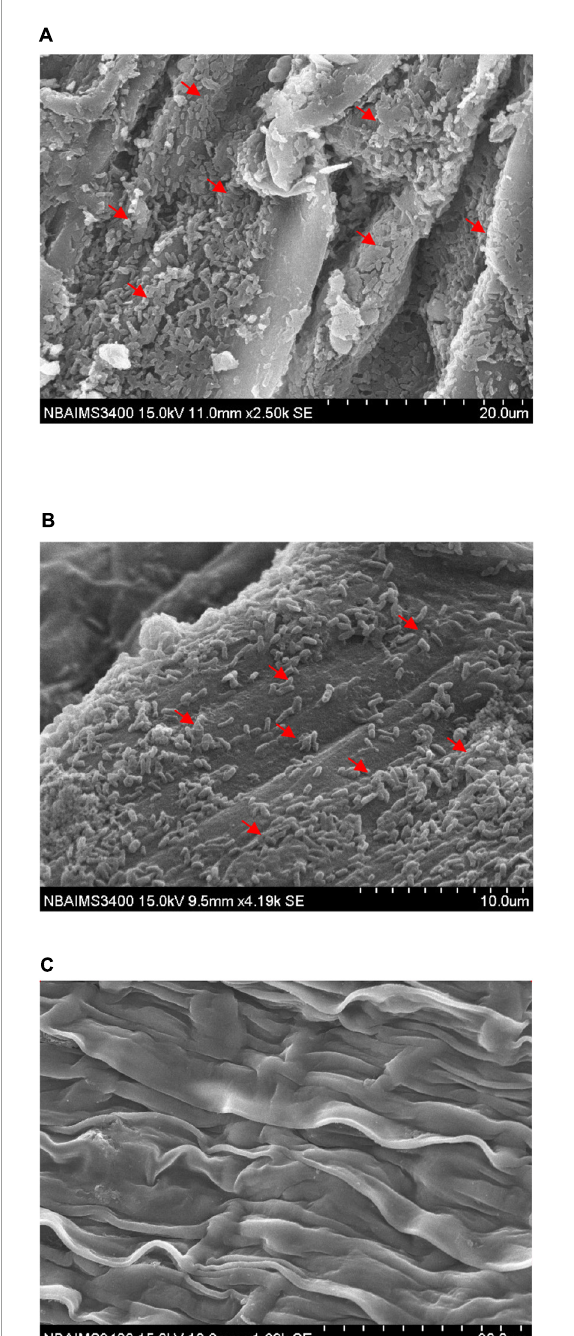
FIGURE2 Scanning electron microphotographs showing root colonization by S. maltophilia DRC-18-7A (A) , S. pavanii DRC-18-7B (B) , and uninoculated control (C) .